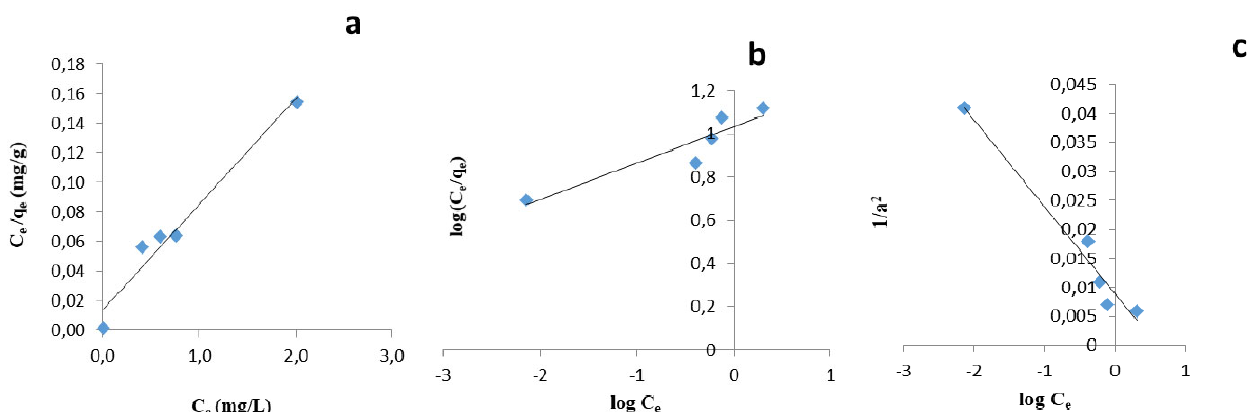
Fig. 13. Linearized Langmuir (a), Freundlich (b) and Harkins-Jura (c) isotherms for the adsorption of Cd 2+ onto SEZ According to (Aly et al., 2014), the values of R L were shown value of R L for synthetic zeolite-Y is close to zero (0.019– in Figure 14 are less than one and greater than zero indicat- 0.007) indicating adsorption characteristic is ing the favorable sorption Cd 2+ onto adsorbent. While the